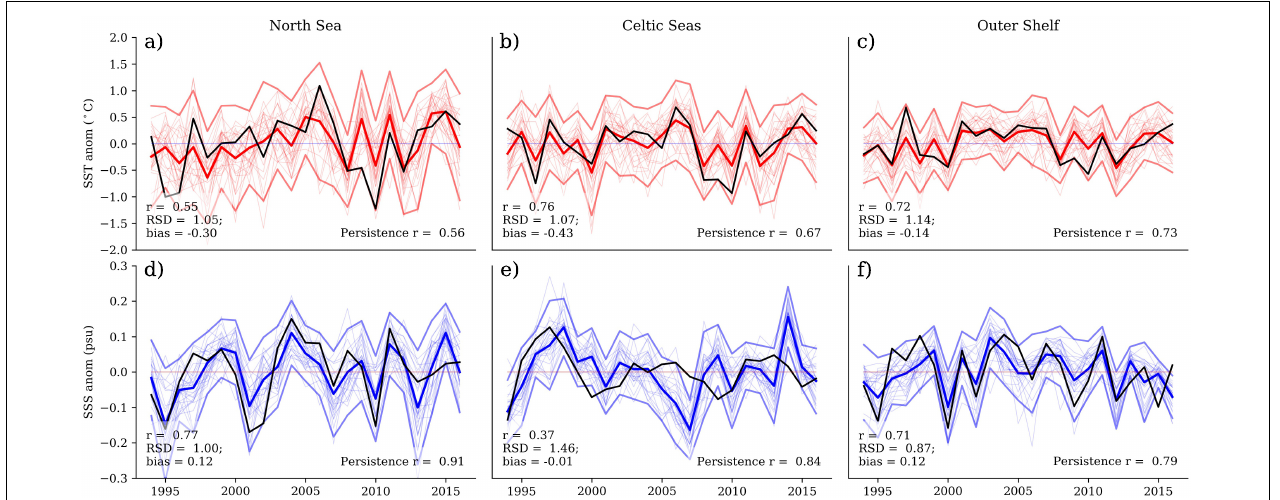
FIGURE 4 | Assessment of GloSea5 predictability of the NWS winter for SST (a–c) and SSS (d–f) . The DJF mean (from each year) is averaged over the validation regions (defined in Figure 1a ). CMEMS is in black. GloSea5 reforecasts (DJF mean predicted from November) are coloured (temperature: red; salinity: blue). Each of the 28-ensemble member is shown as a faint line, and the ensemble mean, and ± 1.96 ensemble standard deviation is shown in bold coloured lines. These are presented as anomalies of the temporal mean of the time series (ensemble mean for the GloSea5 data). The correlation skill ( r ), relative standard deviation ( RSD , taking the variability of the ensemble into account), bias and (Eulerian) persistence skill is given for each panel. NBT is given in Supplementary Figure 9 .